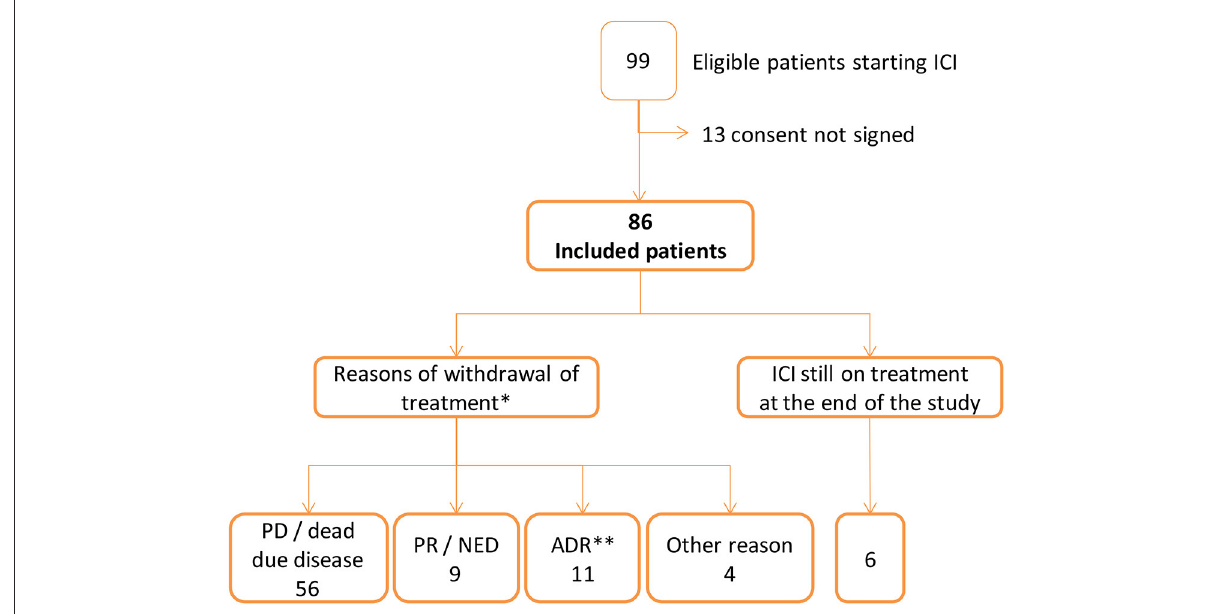
FIGURE1 Flow chart of patients starting immune checkpoint inhibitors (ICI). *PD, progression disease; PR, partial response; NED, no-evidence disease; ADR, adverse drug reaction. **ADR was the only reason for ending treatment in 6 patients: adrenal insufficiency and cholestatic liver injury (1), acute renal insufficiency (1), interstitial pneumonitis (1), bipulmonary infiltrates (1), hypopituitarism (1), autoimmune colitis and cytomegalovirus gastrointestinal infection (1). In 5 patients there were additional reasons: pruritus and PD (1), adrenal insufficiency and PD (1), hyperamylasaemia and NED (1), dermatitis psoriasiform and rash and PR (1) and diarrhoea and PR (1). Other reasons of ending ICI treatment were appendicitis (1 patient), ictus (1), patient withdraw consent at the third visit (1), cognitive impairment identified at the second visit